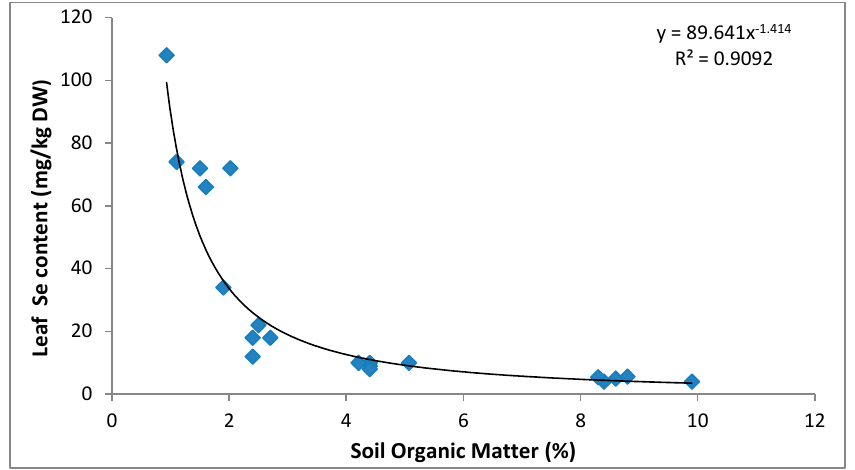
Figure 3. Relationship between soil organic matter and Se content of lettuce and berseem crops grown in soils with a pH range of 6.1 to 8.1 amended with sodium selenate. Table 5. Soil organic matter and Se content (mg/kg dry weight) of lettuce and berseem crops grown